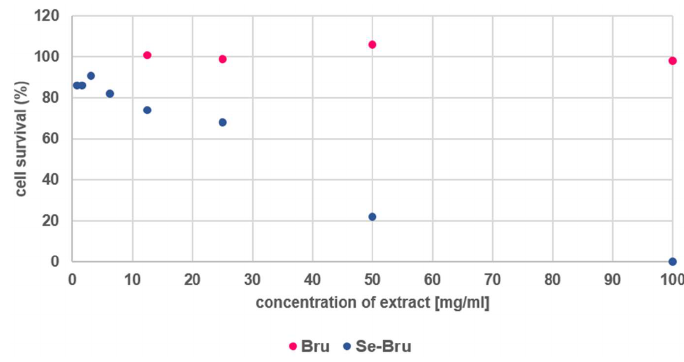
Figure 6. Survival of the cells after the exposition.